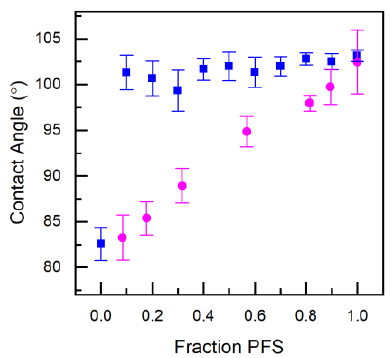
Figure 5. Contact angle measurements of PFS/MMA thin-film copolymers (circles) and PFS/MMA thin-film blends (squares) formed from spin-coating a 50mg/mL solution in MEK solvent after annealing at 150 °C for 2 h.